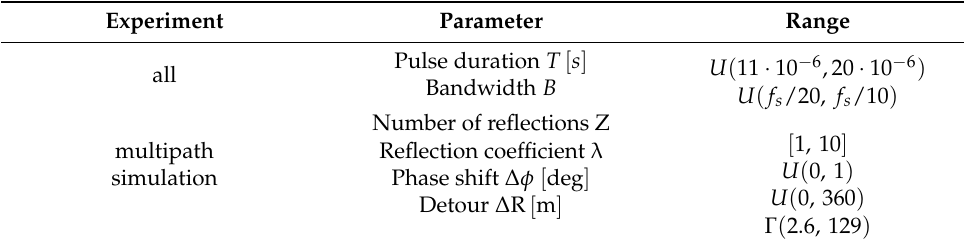
Table 2. List of simulation